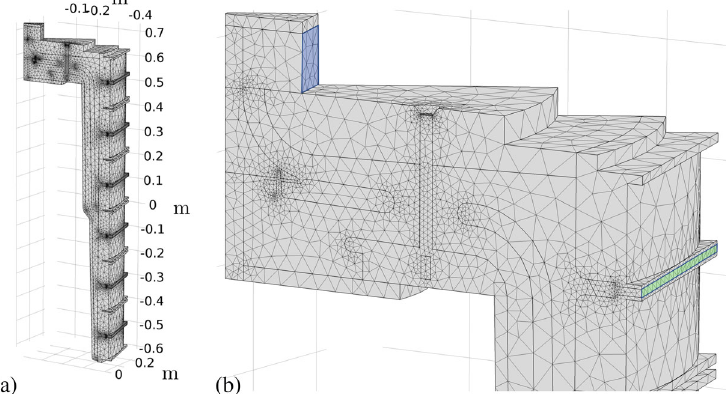
FIG. 5. (a) An overall view of the typical mesh used for the simulations. The mesh is generated directly from the CAD drawings. (b) Enlarging the mesh around the convolute region shows how the A-K gap of the cavity and the post-hole convolute are meshed. The light green region is the port where the LTD equivalent circuit shown in Fig. 4(b) is connected. The light blue region corresponds to the port connection of the load equivalent circuit. Several “ vacuum ” volumes were added under the load region to close the simulation domain, avoiding meshing the volume surrounded by the bottom